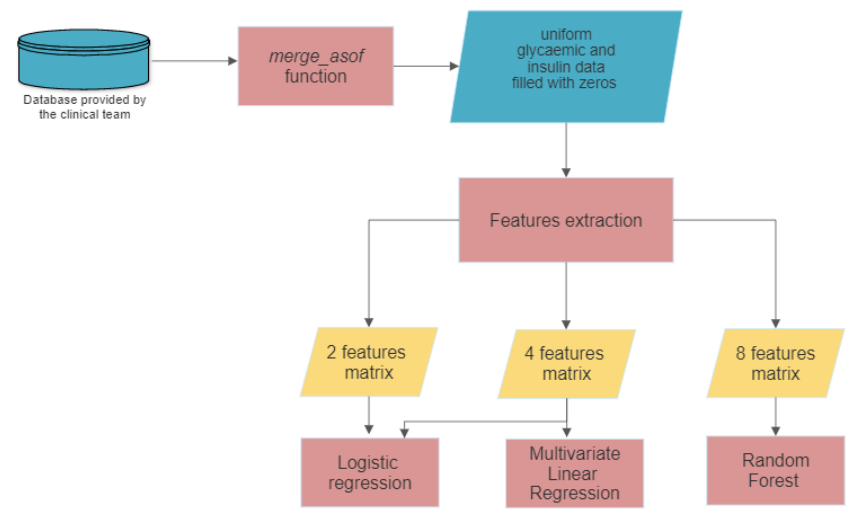
Figure 1. Pre-processing steps for the Machine Learning